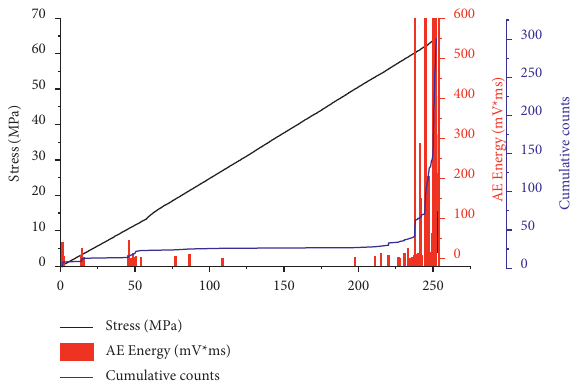
Figure 6: AE characteristic curve of rock under uniaxial